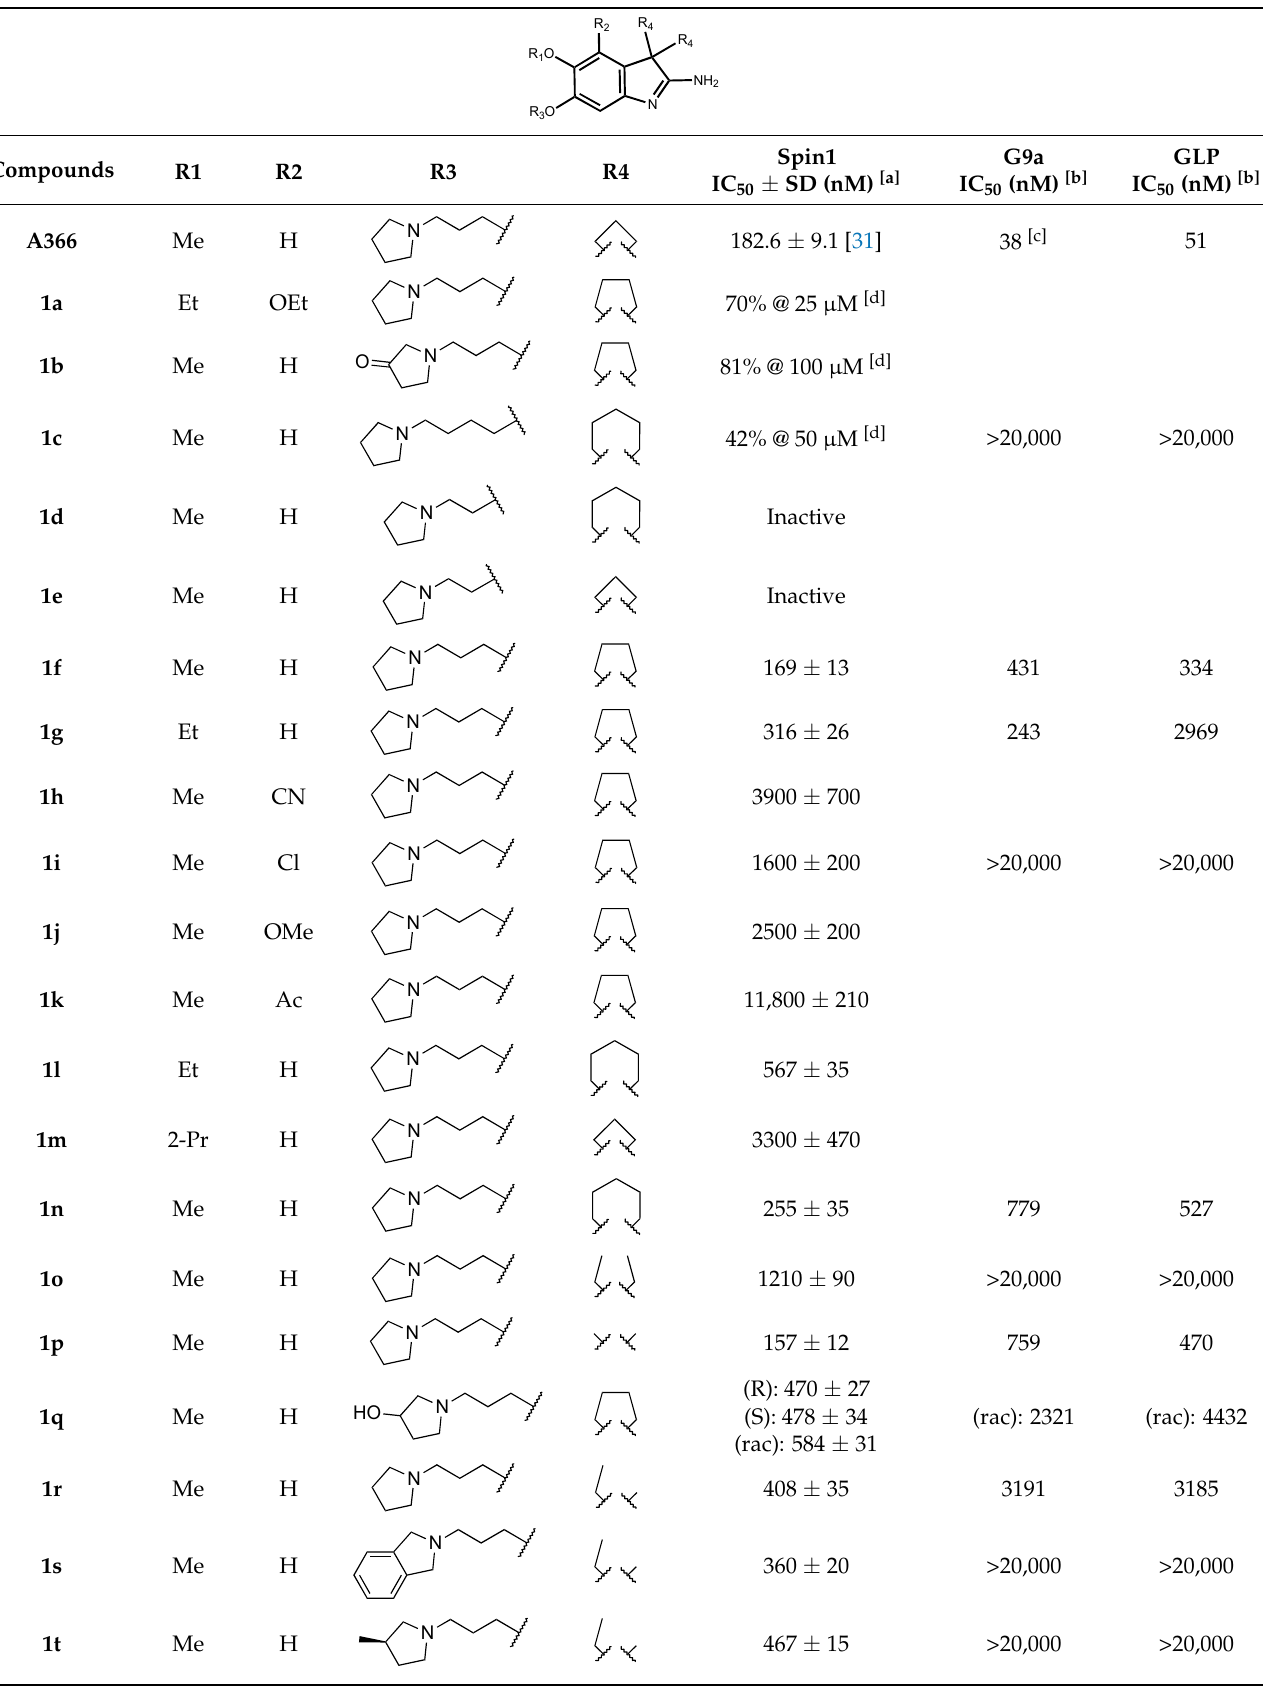
Table 1. Chemical structures and inhibitory activity of the A366 derivatives.